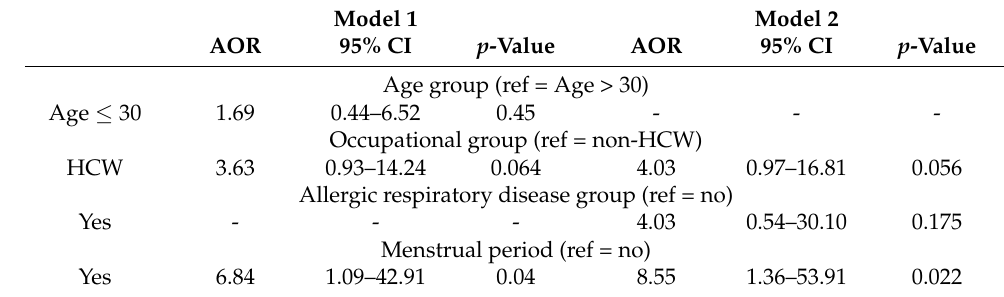
Table 5. Multivariable conditional logistic regression analysis to estimate the odds of